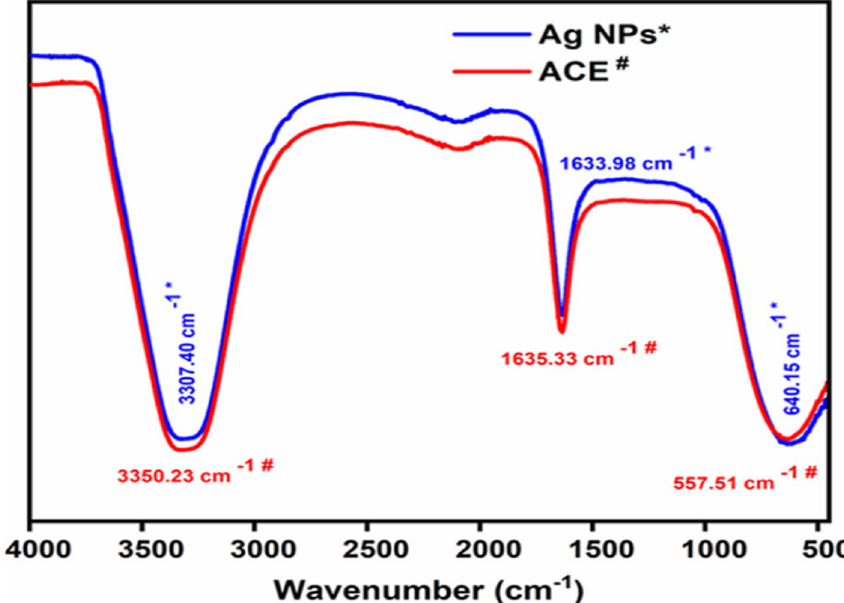
Figure 3. The ATR-FTIR spectra of ACE and Ag. NPs of Plantago lanceolata .